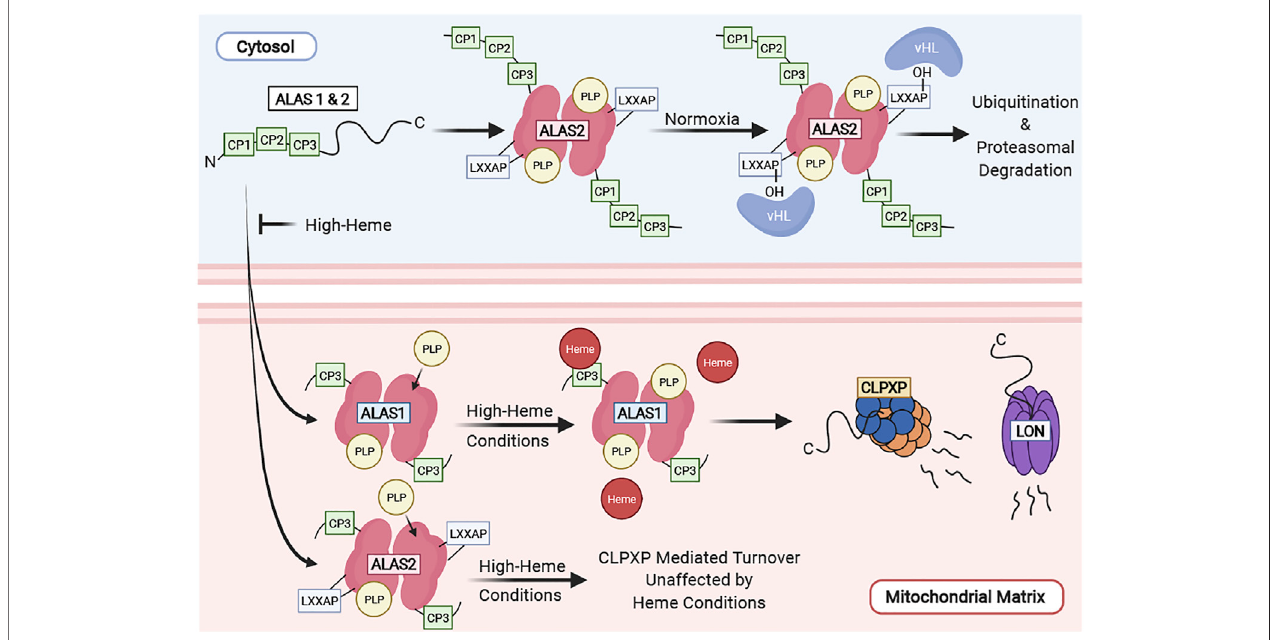
FIGURE 3 | Regulation of ALAS in the cell. ALAS translocation to the mitochondrial matrix is inhibited by high heme conditions and functions as a mechanism of feedback inhibition. ALAS2 turnover is regulated by the ubiquitin-proteasome system in the cytosol and by CLPXP in the mitochondria. ALAS1 is tightly regulated by mitochondrial heme levels. High heme concentrations facilitate its degradation by the CLPXP proteolytic complex and Lon in the mitochondria.